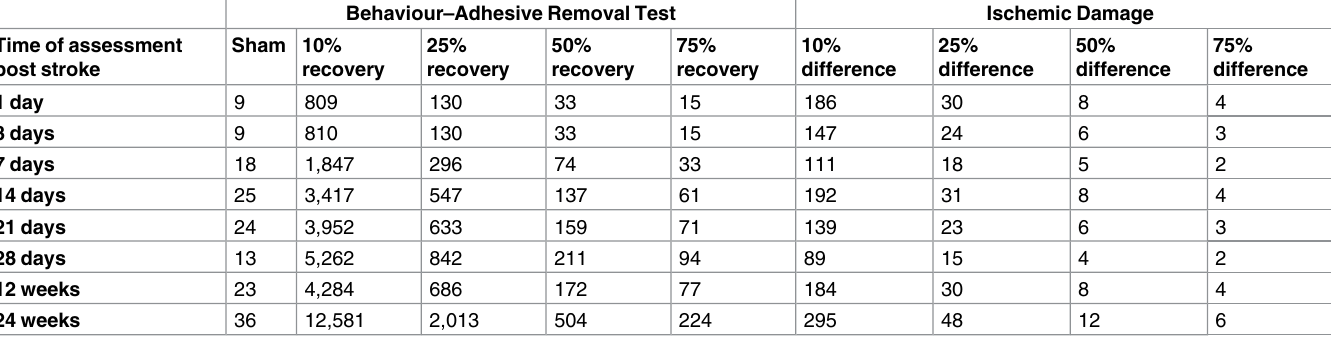
Table 3. Sample size calculations for behavioural and histological based outcome measures. Behaviour–Adhesive Removal